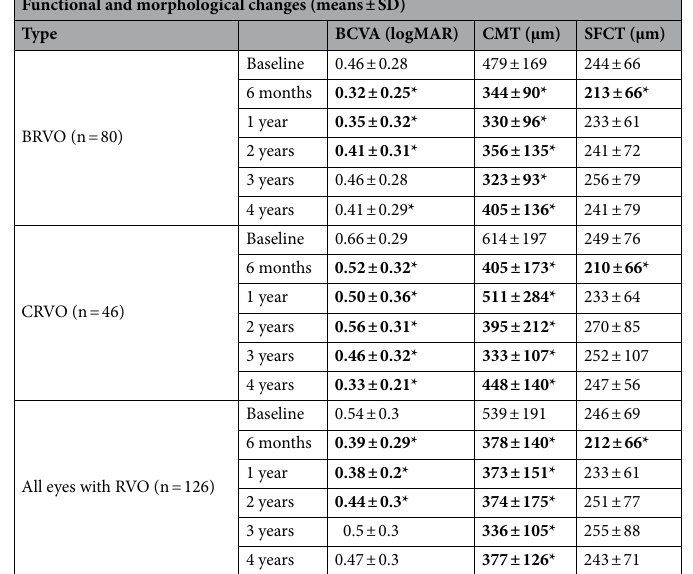
Table 4. Functional and morphological changes. Significant values are in bold. SD standard deviation, BCVA best-corrected visual acuity, CMT central macular thickness, SFCT subfoveal choroidal thickness, RVO retinal vein occlusion, BRVO branch retinal vein occlusion, CRVO central retinal vein occlusion. *p-value < 0.05 when compared to baseline.